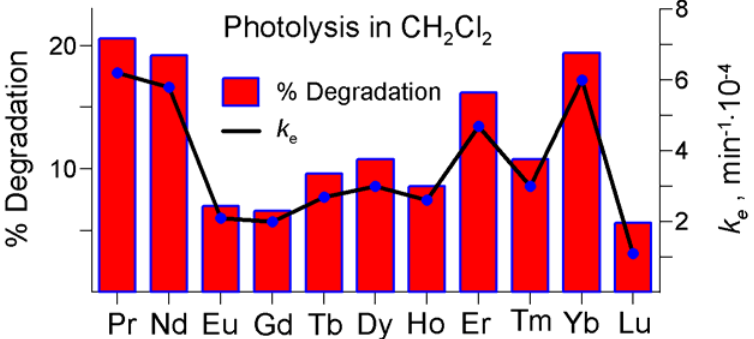
Figure 13. Degradation degree (%) and effective reaction rate constants, k the photolysis carried out in dichloromethane (for details see Table